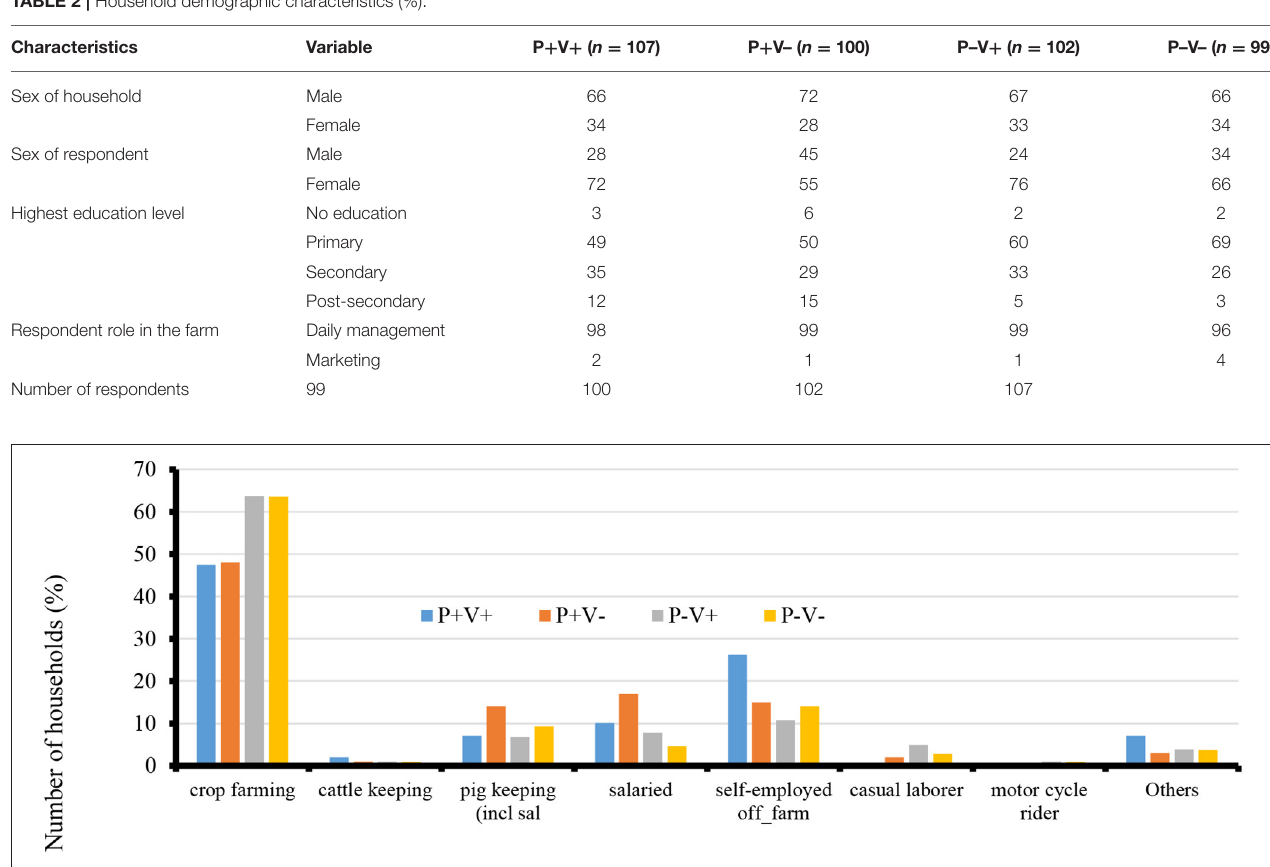
FIGURE 2 | Main household income sources for the